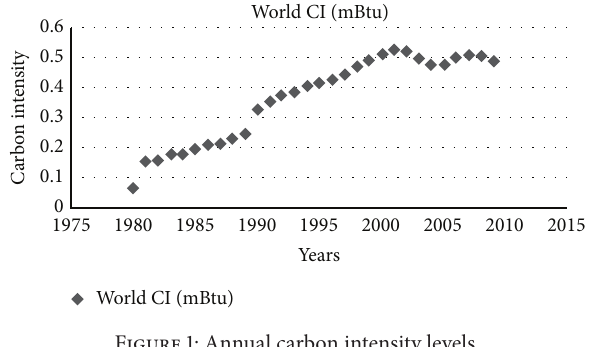
Figure 2: Annual crude oil